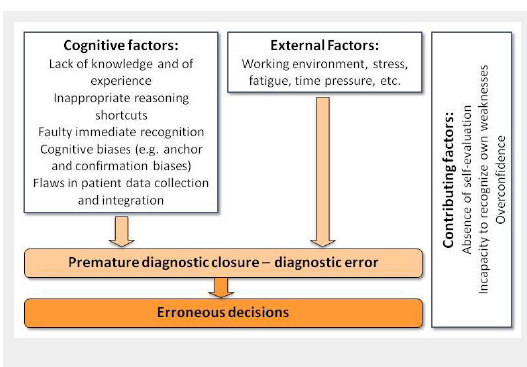
Cumulative conditions conducting to diagnostic and decision